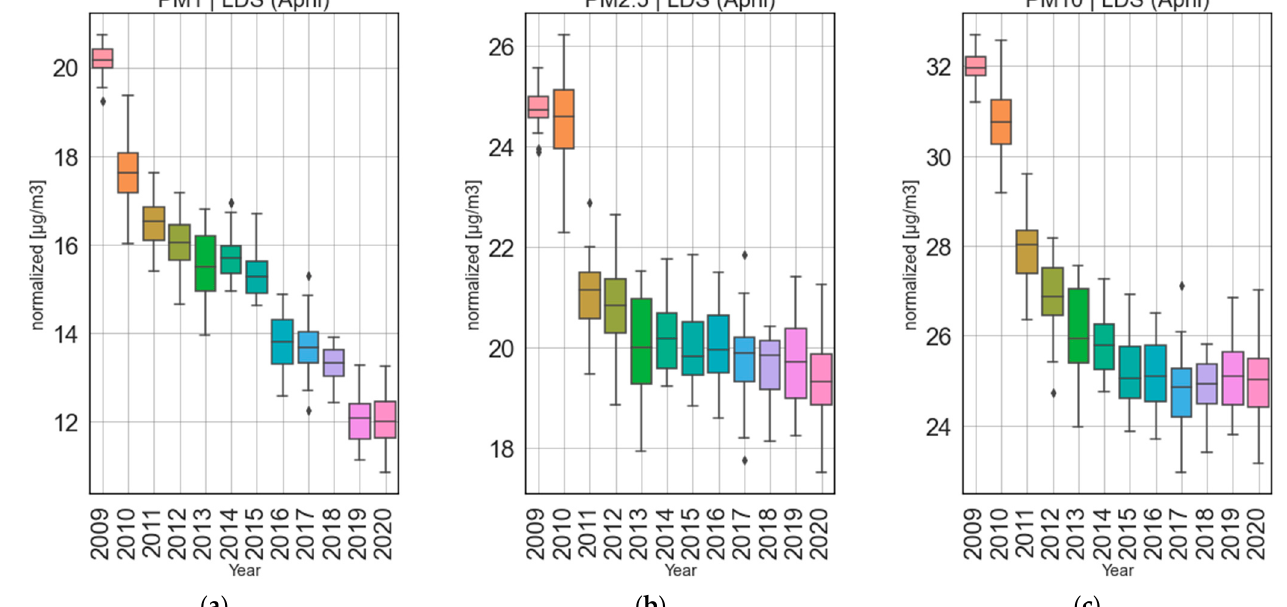
Figure 7. Boxplots of April normalized concentrations through the years for ( a ) PM 1 , ( b ) PM 2.5 , ( c ) PM 10 . The boxes show the quartiles of the dataset while the whiskers show the rest of the distribution, except for points that are determined to be “outliers” (diamond-shaped markers) by being outside of the inter-quartile